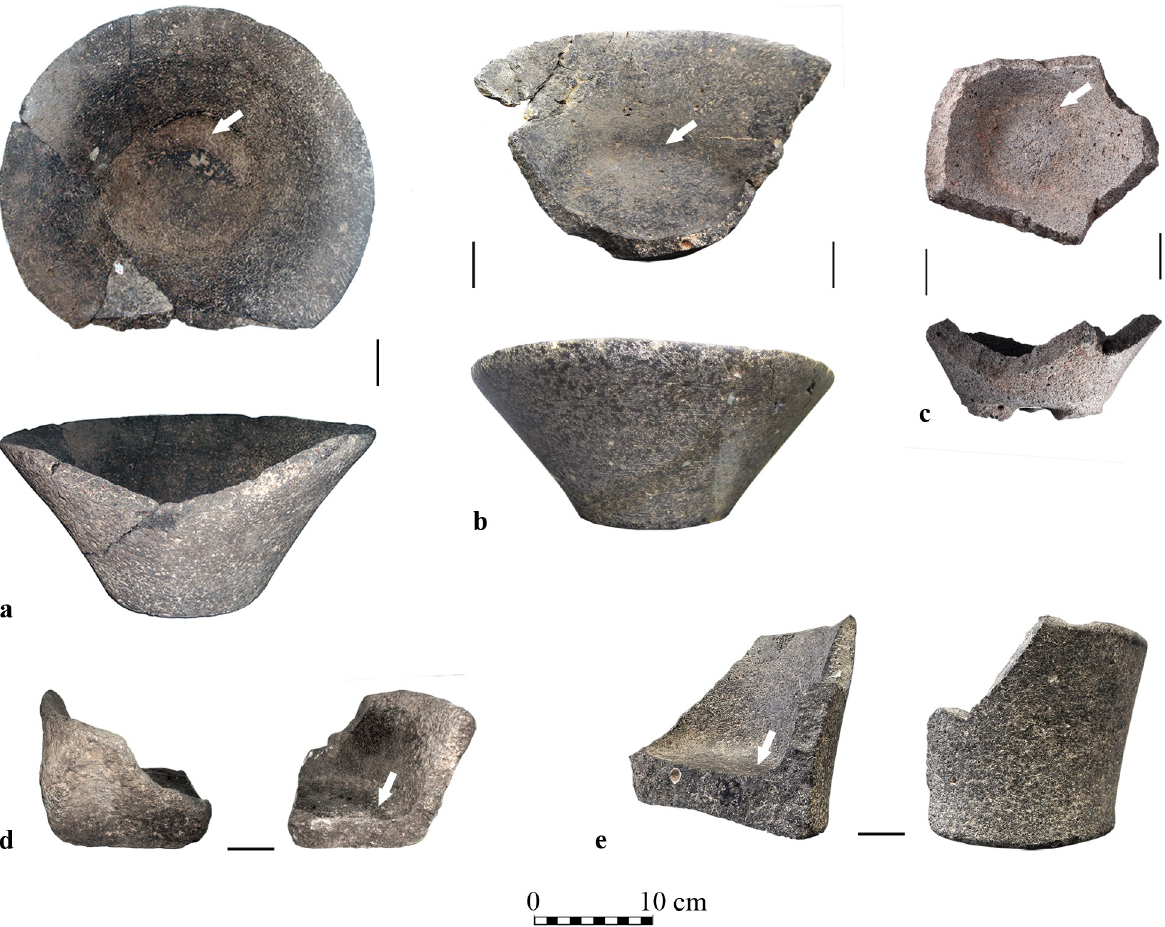
Fig 1. Examples of basalt vessels from the current study with a circumferential depression (marked by arrows). (a) V-shaped bowl from Giv’at HaOranim; (b) V-shaped bowl from Shiqmim; (c) Fragment of a fenestrated pedestal bowl from Namir Road; (d) Fragment of a four-handled bowl from Tel Bet Yerah; (e) Upright bowl from